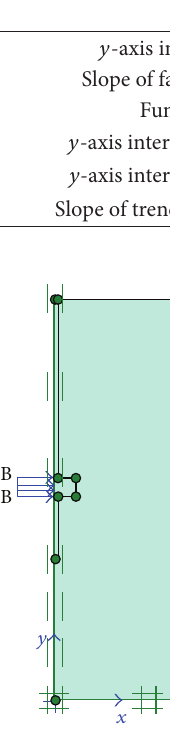
Figure 4: Boundary conditions and loading